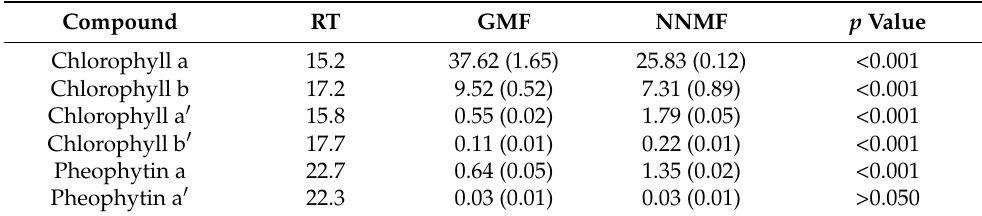
Table 1. Chemical characterization of Lima bean chlorophylls in plants exposed to GMF and NNMF conditions. Values are expressed as µ g g − 1 F.Wt (standard deviation). p value refers to differences in chlorophyll content between GMF- and NNMF-exposed plants.